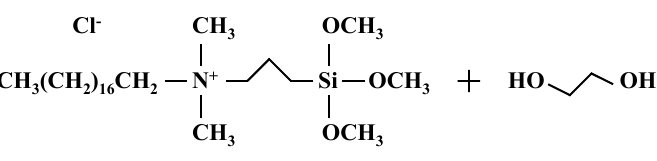
Figure 2. Chemical structure of the Zycosoil.